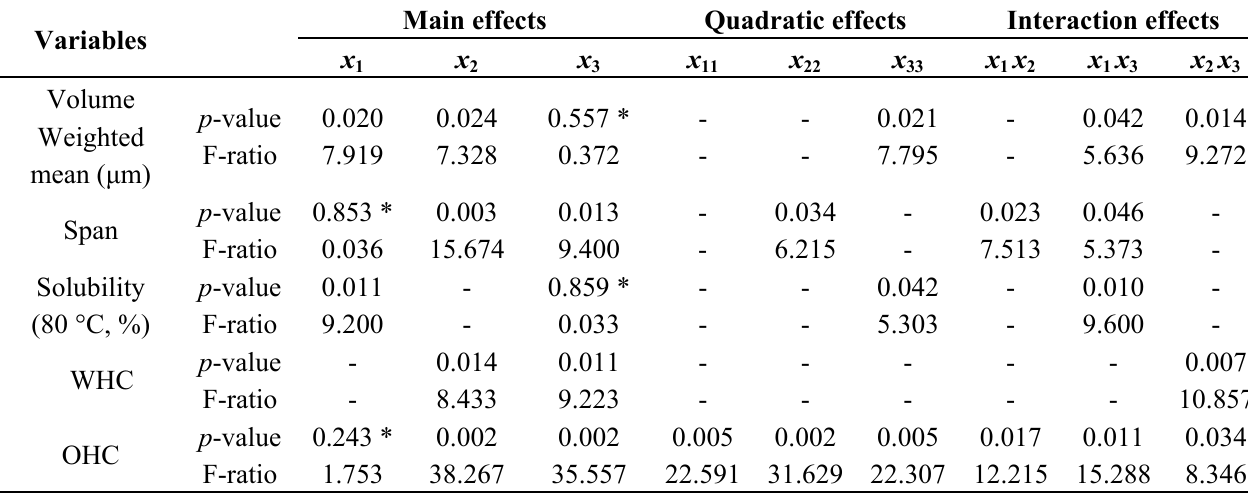
Table 2. p -Value and F-ratio of chemical extraction variables in final reduced models.